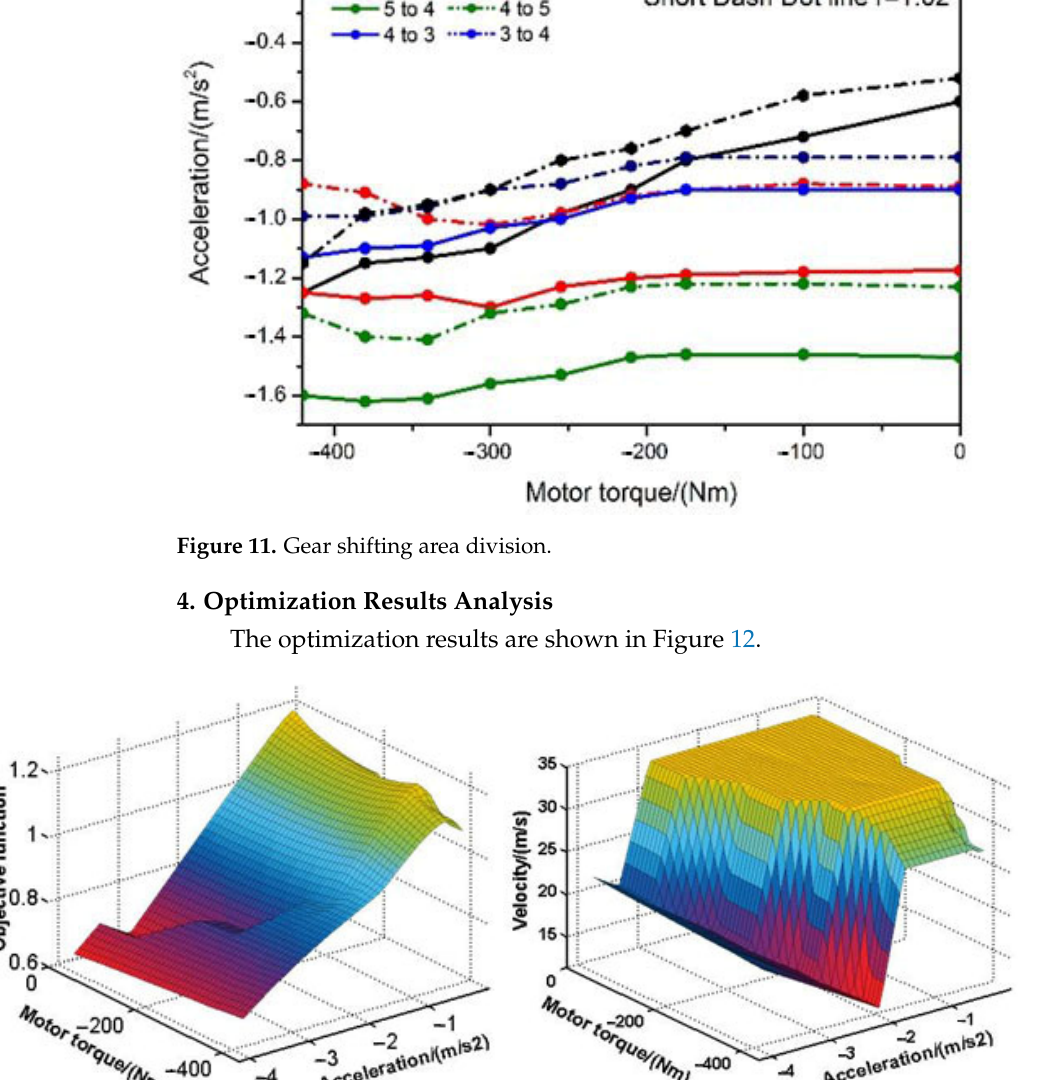
Figure 12. Gear shifting schedule in different gears (5 to 4).